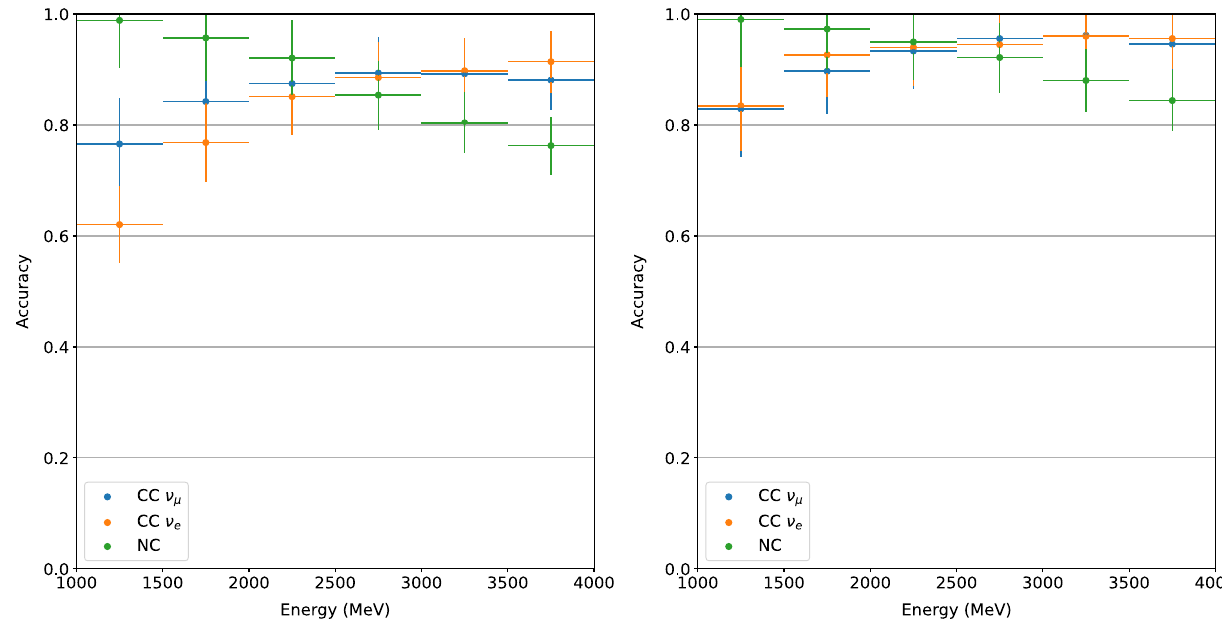
Fig. 6 The classification accuracy for each interaction type as a function of the true neutrino energy for the Kaiming-initialised (left) and transfer learning all weights (right) cases for networks trained with 100,000